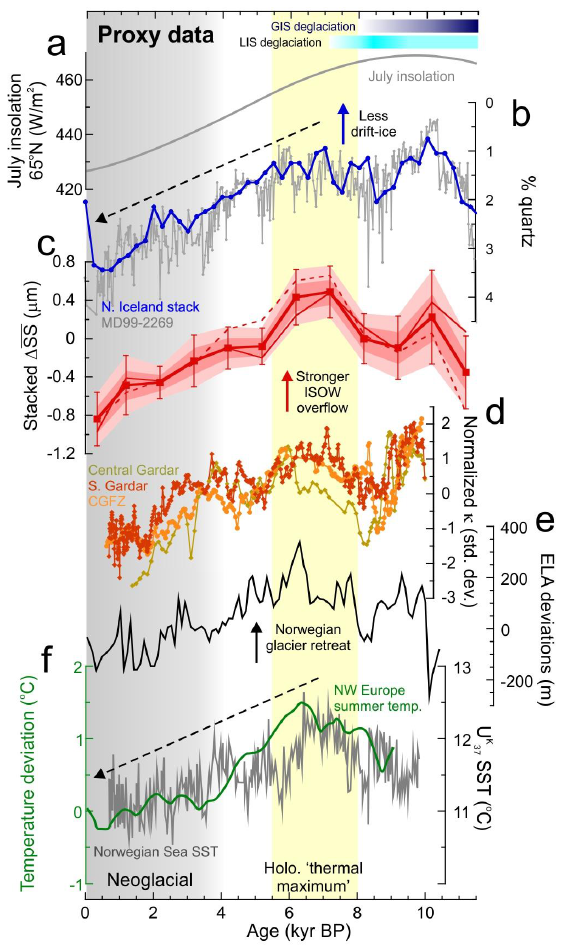
Fig. 5. Comparison between the estimated changes in Iceland– Scotland overflow strength and climate proxies: (a) coloured bars indicate intervals of ice sheet retreat (see the Supplement); grey line is July insolation at 65 ◦ N; (b) percent abundance of quartz grains in North Iceland shelf sediment cores, a proxy for drift ice abundance (multi-year sea ice and ice bergs) within the East Green- land Current and East Icelandic Current advance (blue line, stack record including up to 20 cores (Andrews et al., 2009); grey line, high-resolution data (Moros et al., 2006) from core MD99-2269); (c) Iceland–Scotland overflow strength (as in Fig. 1d, although the plot of the 500yr offset bins has been excluded to simplify the plot); (d) magnetic susceptibility data, interpreted as a proxy for the flow strength of ISOW along Gardar Drift (data for each individual core have been normalized to aid comparison on a single plot; data from two cores located at Charlie Gibbs Fracture Zone (CGFZ) have been combined) (Kissel et al., 2013); (e) equilibrium line altitude curve for Jostedalsbreen glacier, Norway, recording glacier retreat (Nesje et al., 2001); and (f) green line, Northwest Europe summer temper- atures based on chironomid and pollen lake records from Scandi- navia (Renssen et al., 2009); grey line is alkenone-based sea-surface temperature data from the Norwegian Sea (Jansen et al.,